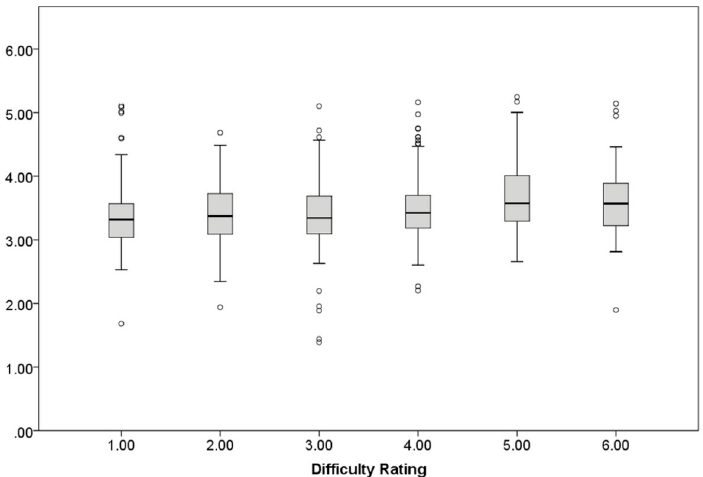
Fig 2. Hypothesis 1 tonic pupil diameter. Mean tonic pupil diameter (in mm) as a function of pathologists’ difficulty rating of each image. Boxplot represents data median (horizontal line), quartiles (shaded), minimum and maximum (error bars), and outliers (dots: 1.5 times the interquartile